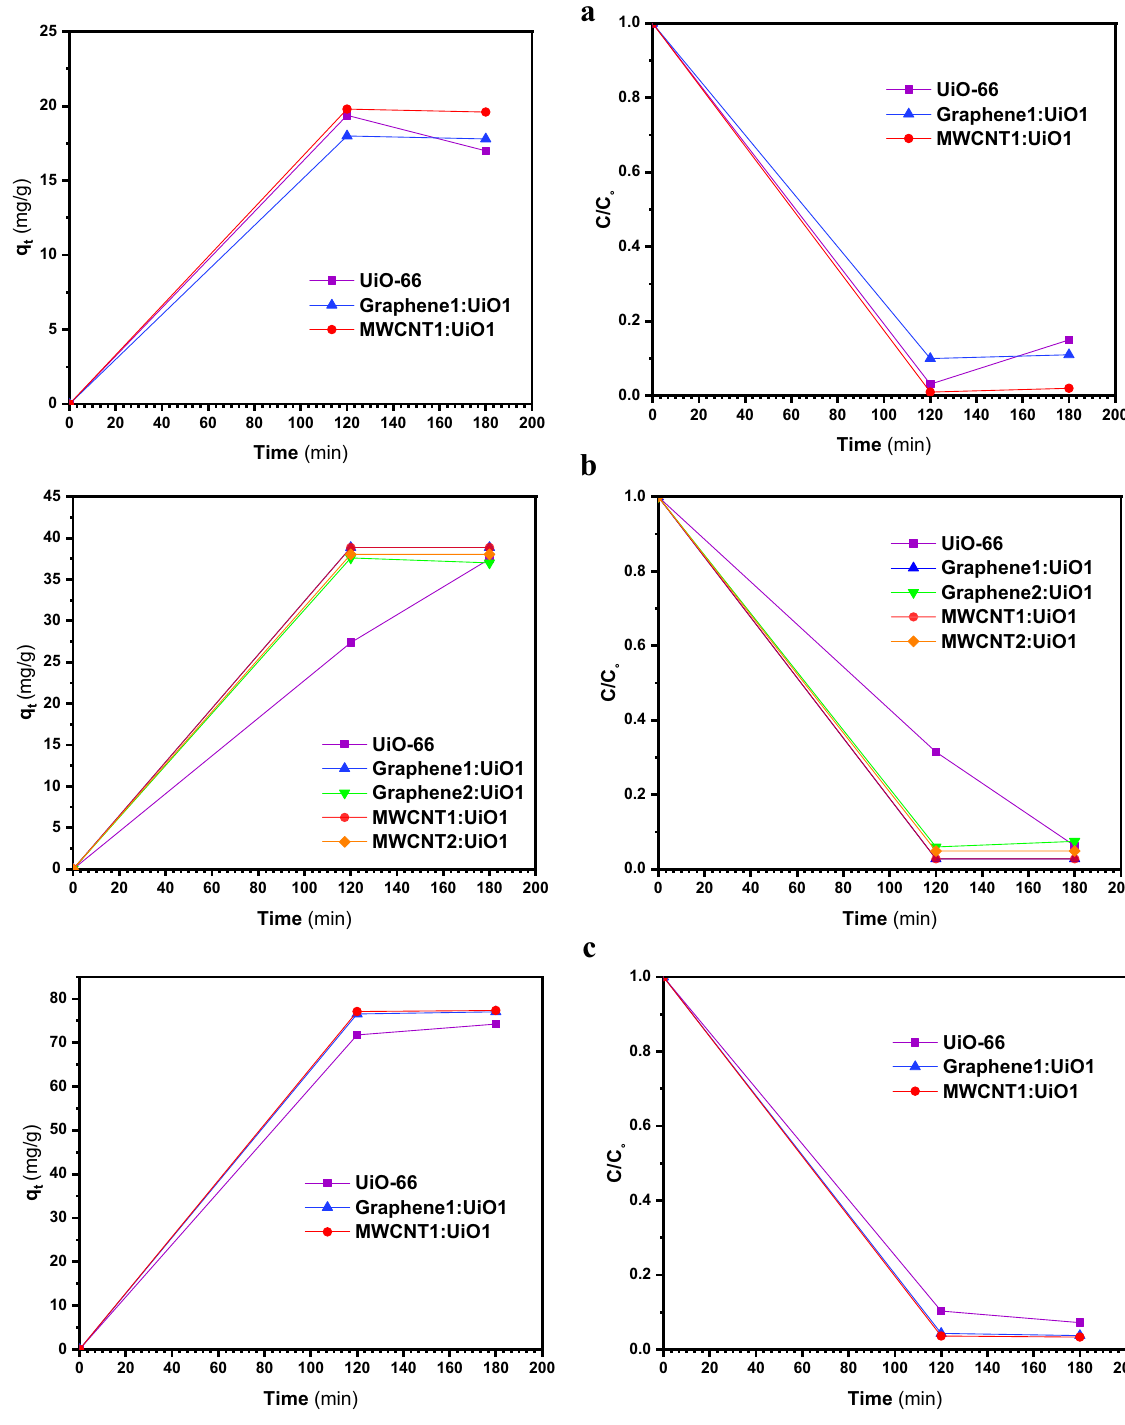
Figure 6. Adsorption capacity and solution concentration versus contact time of MR at different concentrations including ( a ) 10 ppm, ( b ) 20 ppm, ( c ) 40